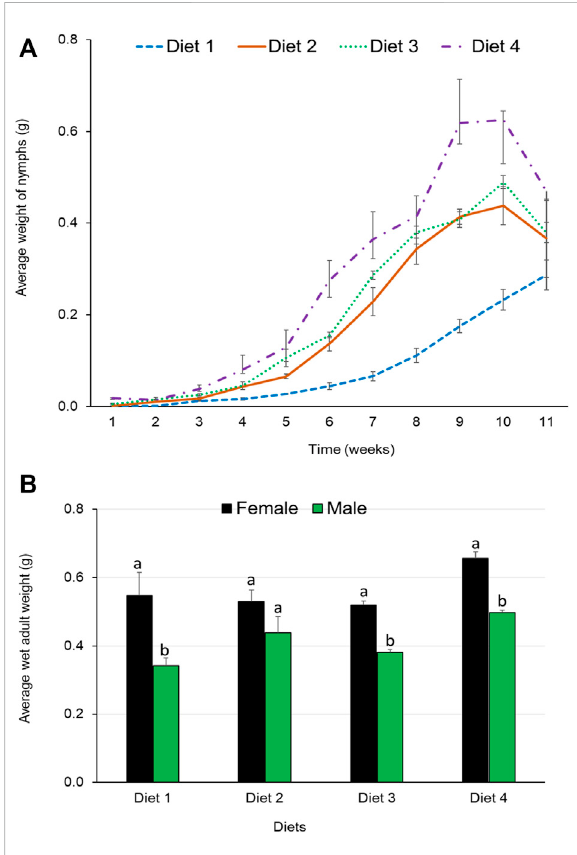
(A) Mean weekly wet weights of nymphs and (B) mean wet weights by sex of adult Ruspolia differens raised on different